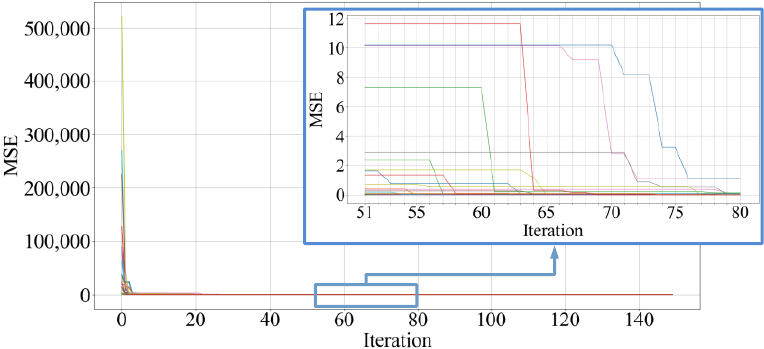
Figure 12. Convergence curves for 24 h for the SSA method.